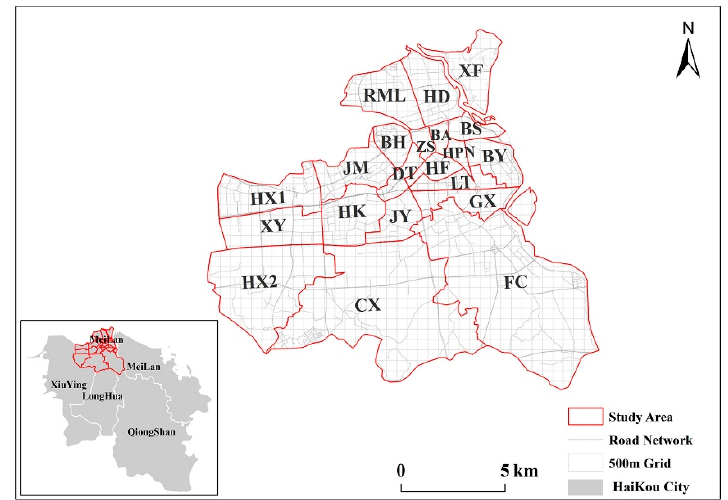
Figure 4. Study Area. BS, BaiSha Street; BL, BaiLong Street; BH, BinHai Street; BA, BoAi Street; CX, ChengXi Town; DT, DaTong Street; FC, FuCheng Town; GX, GuoXing Street; HD, HaiDian Street; HF, HaiFu Street; HK, HaiKen Street; Hx1, HaiXiu Street; Hx2, HaiXiu Town; HPN, HePingnan Street; JinMao Street; JinYu Street; LanTian Street; RML, RenMinglu Street; XX, XiXiu Town; XF, XinFu Town; XY, XiuYing